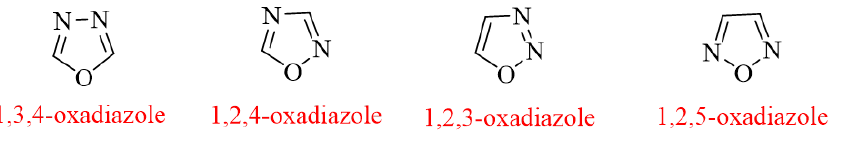
Figure 3. The isomers of oxadiazole.